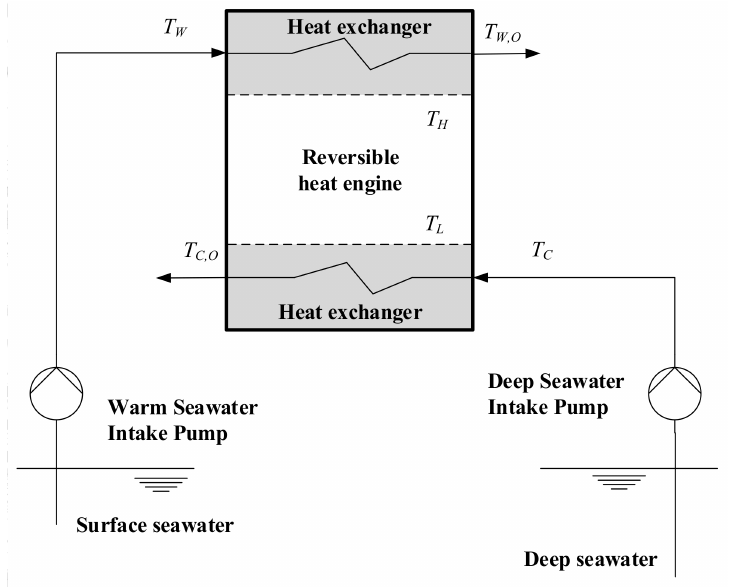
Figure 1. OTEC power generation system model using a reversible heat